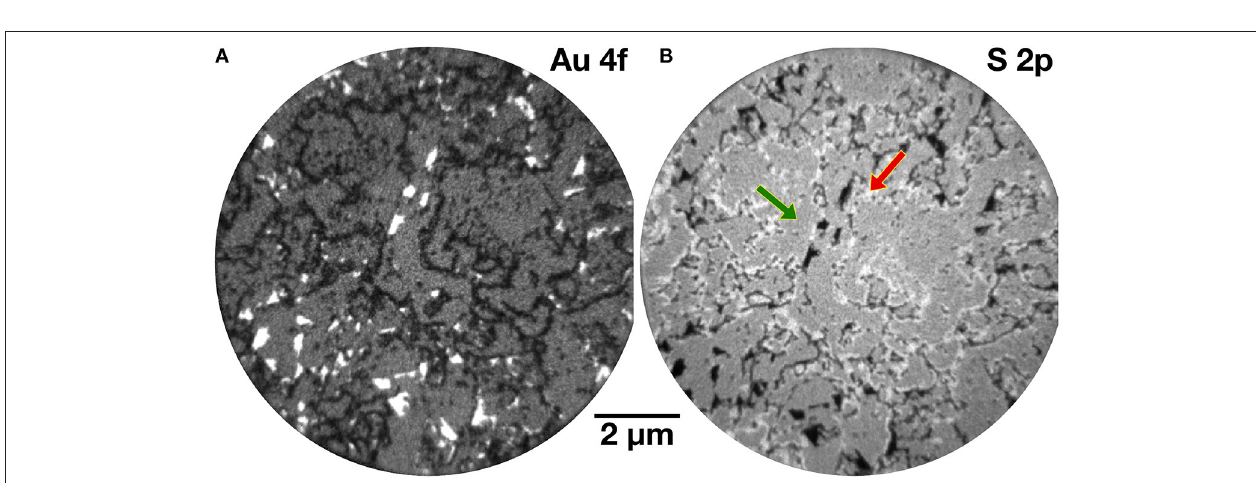
FIGURE 4 | X-ray photoemission electron microscopy (XPEEM) data recorded using Au4f 7 / 2 (A) and S2p 3 / 2 (B) core-level photoelectrons (photon energy h ν ≈ 250eV). In (B) , an exemplary region of intermediate (high) sulfur concentration is marked by a green (red) arrow, respectively. For comparison, the same regions are also marked in the inset of Figure 5